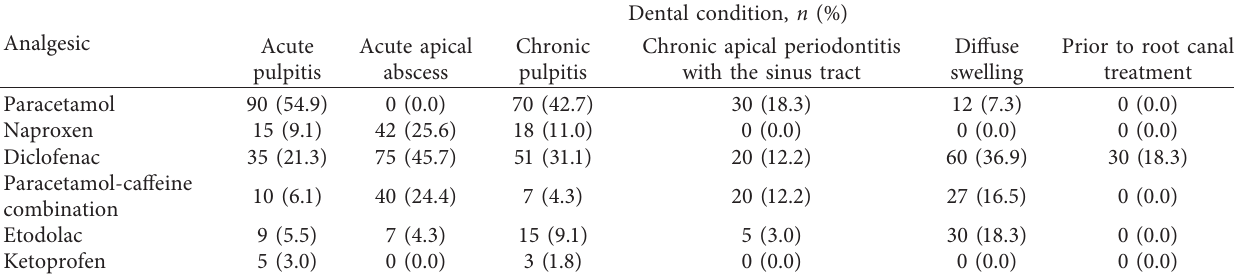
Table 2: Prescribing pattern of analgesics under different conditions.